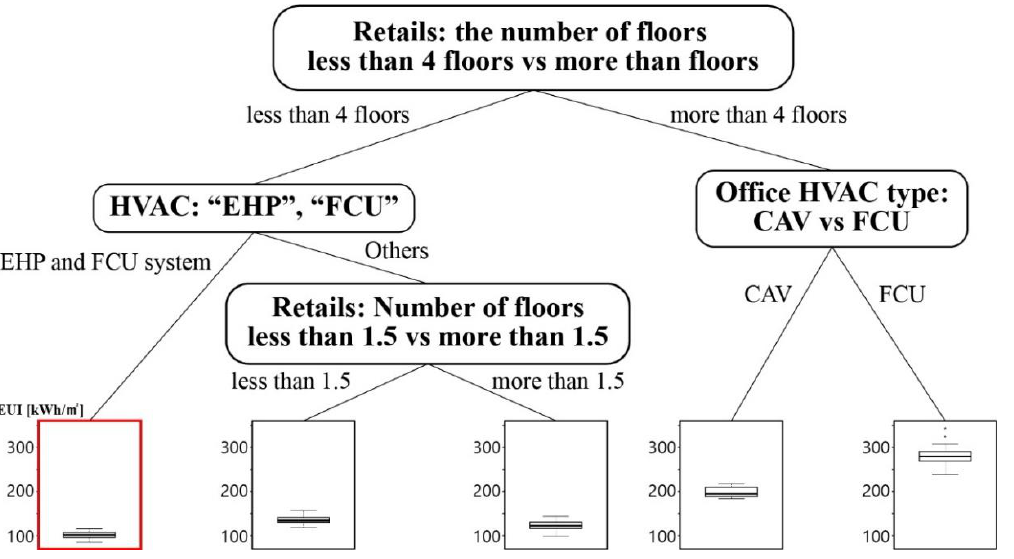
Figure 7. Decision support model by CART.